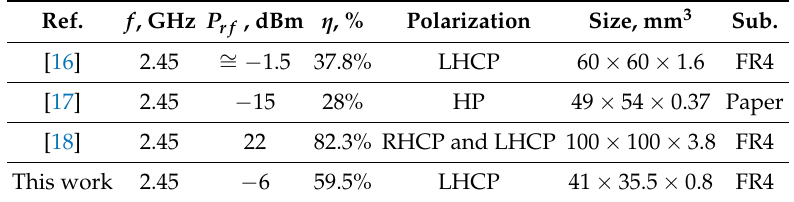
Figure 8. Rectenna simulation and measurement performance characteristics ( a ) efficiency versus frequency at a fixed measured input power − 6 dBm, simulated input power − 4.5 dBm and R L = 1.3 k Ω ; ( b ) efficiency versus terminal load at defined measured input power − 6 dBm, simulated input power − 4.5 dBm and frequency 2.4 GHz. Table 1. Comparison of this study with the relevant research work in